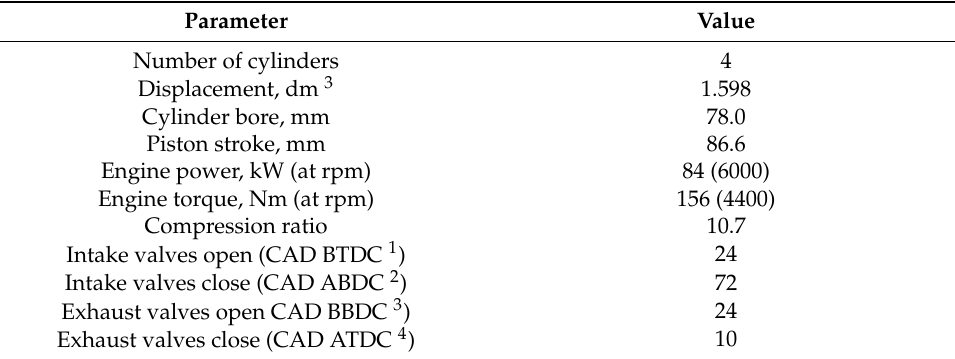
Table 1. Technical characteristics of SI engine HR16DE.